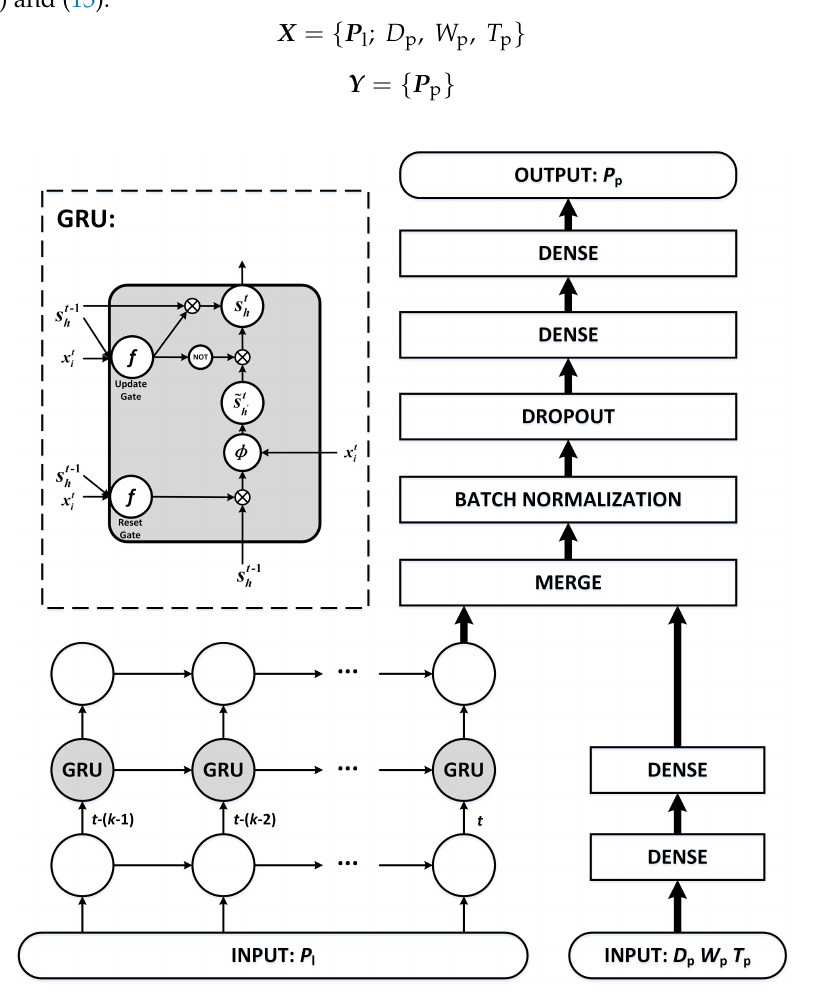
Figure 5. Schematic diagram of proposed framework based on GRU Neural Networks for short-term load forecasting, where k is the number of hidden units and t is the time step. The parameters of GRU units are clarified in Section 2.1. The input and output parameters are explained in the next